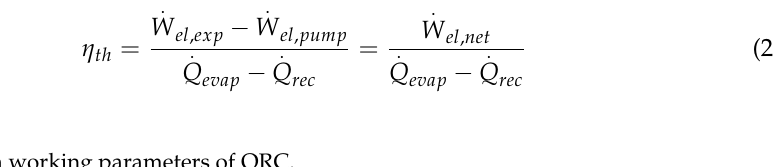
Table 4. On-design working parameters of